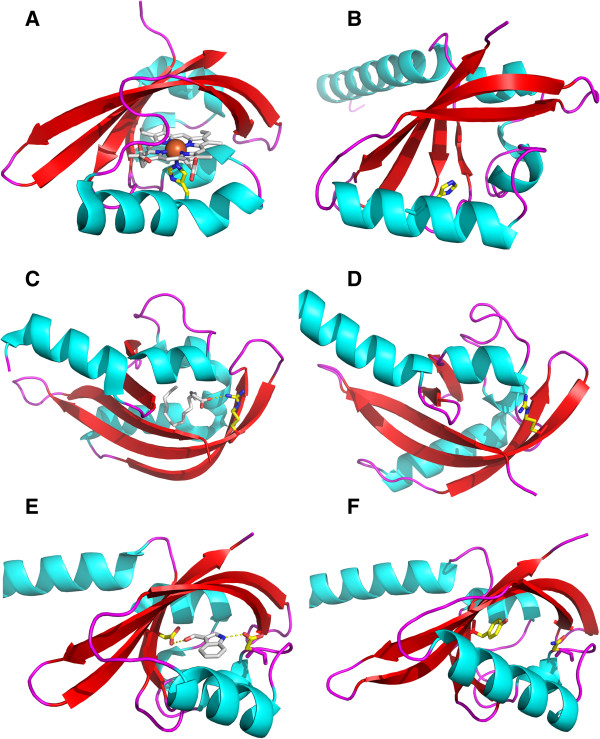
Close-up views of regions targeted by site-directed mutagenesis. The structures of PAS domains used to select the residues to replace are shown on the left (A,C,E), and the corresponding views of the PASBvg model are shown on the right (B,D,F). The residues that were replaced are colored yellow. A, FixLBj PAS domain (pdb code: 1DRM), with the heme colored grey. C, PAS domain of the M. tuberculosis Rv1364c protein (pdb code: 3KC3), showing the fatty acid in the cavity (in grey). E, cavity of PASHm (pdb code: 3BWL) with the Asp side chains (in yellow) pointing to the 1H-indole-3 carbaldehyde ligand (in grey). In PASBvg(F) the corresponding residues are Tyr596 and Asn631.